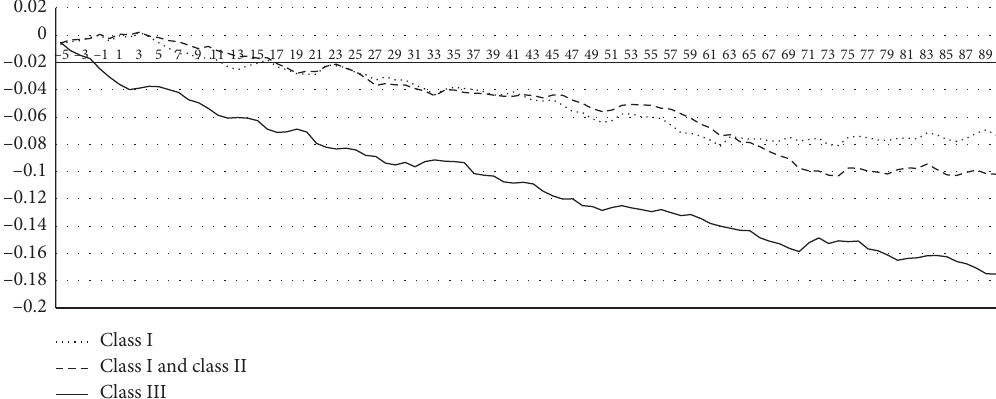
Figure 1: Cumulative average abnormal returns over